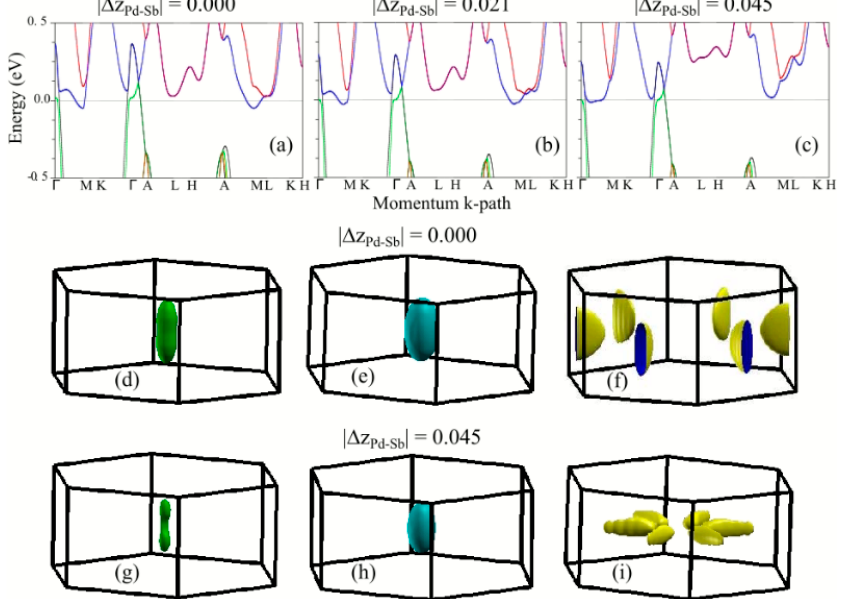
Figure 4. DFT electronic structure calculations for LaPdSb: panels ( a – c ) show the electronic band structure for three values of the puckering strength corresponding to crystal structures described in the text; panels ( d – f ) show the Fermi surfaces corresponding to the band structure from panel ( a ) and panels ( g – i ) show the Fermi surfaces corresponding to the band structure from panel ( c ).